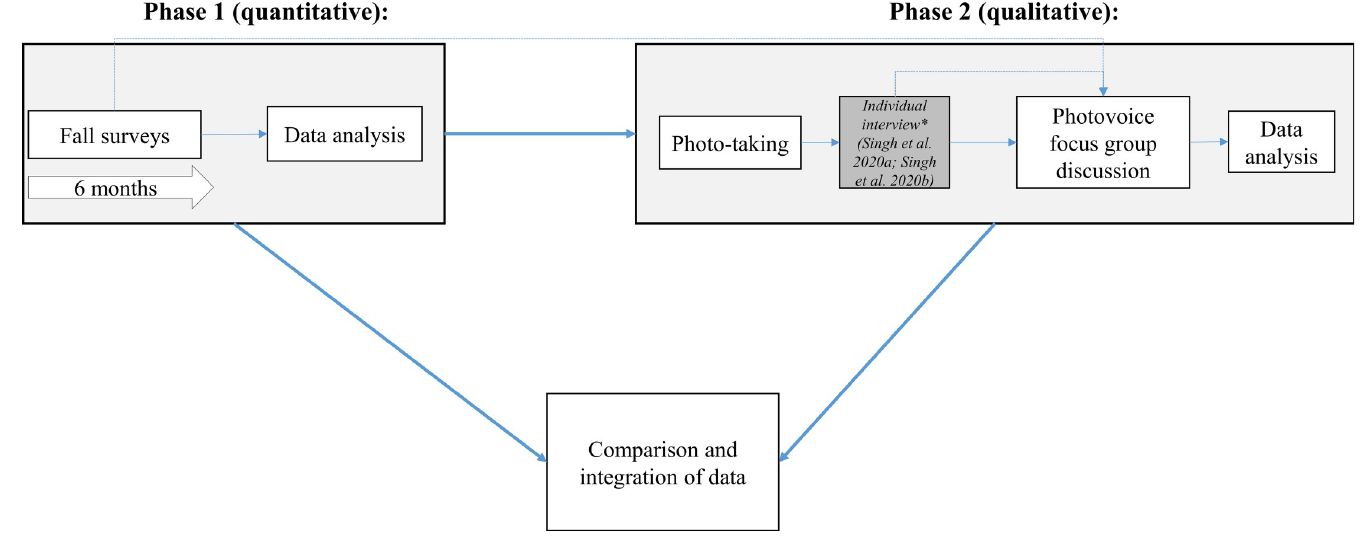
Fig 1. Mixed methods